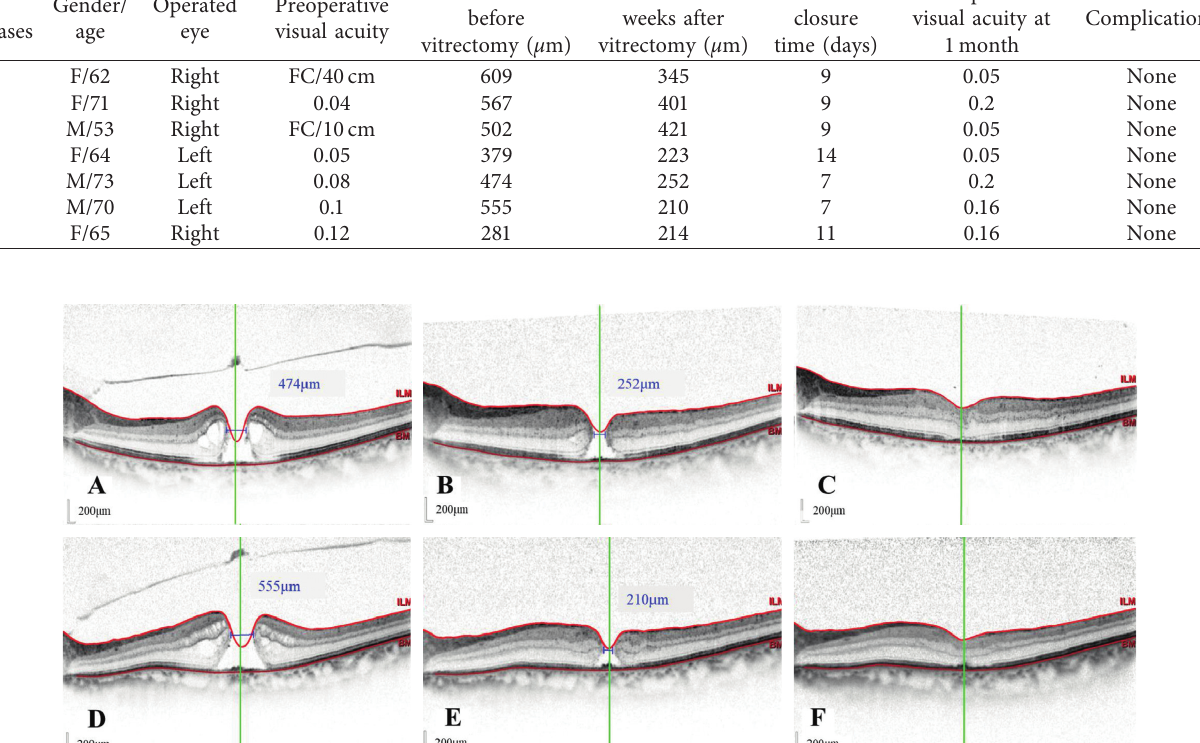
Figure 2: The size of macular holes in three patients before and after surgery. A–C: the size of the macular hole before vitrectomy, before gas-liquid exchange in patient 5, and the macular hole closed 7 days after gas-liquid exchange; D–F: the size of the macular hole before vitrectomy, before gas-liquid exchange in patient 6, and the macular hole closed 7days after gas-liquid